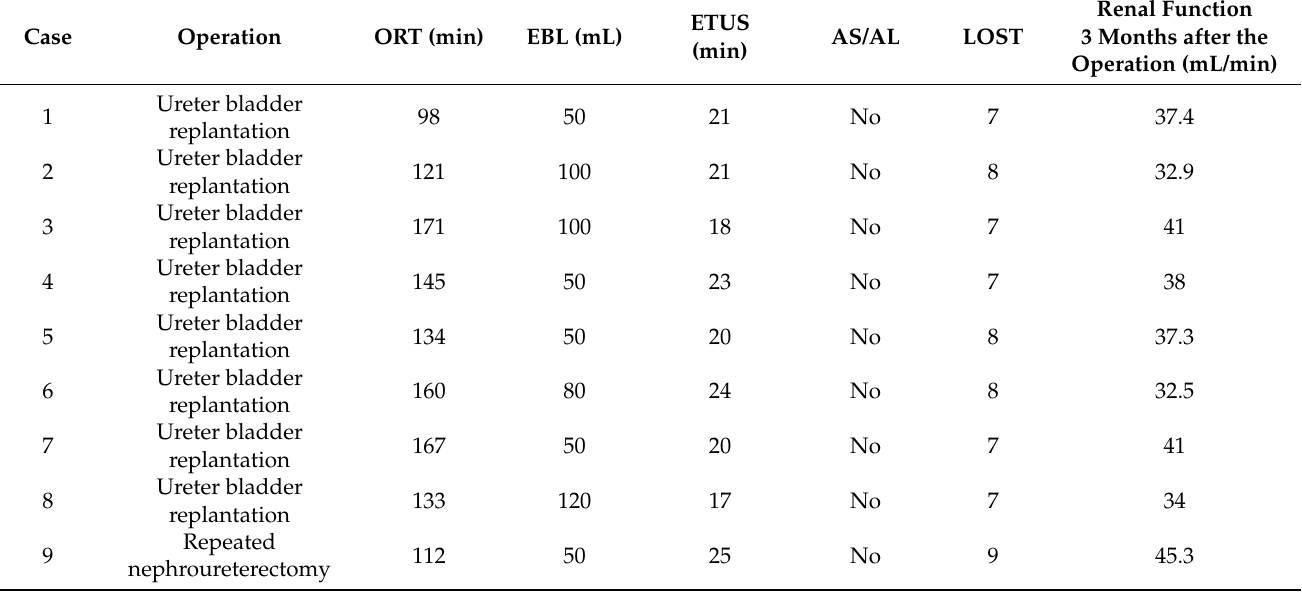
Table 2. Intraoperative and postoperative information of 14